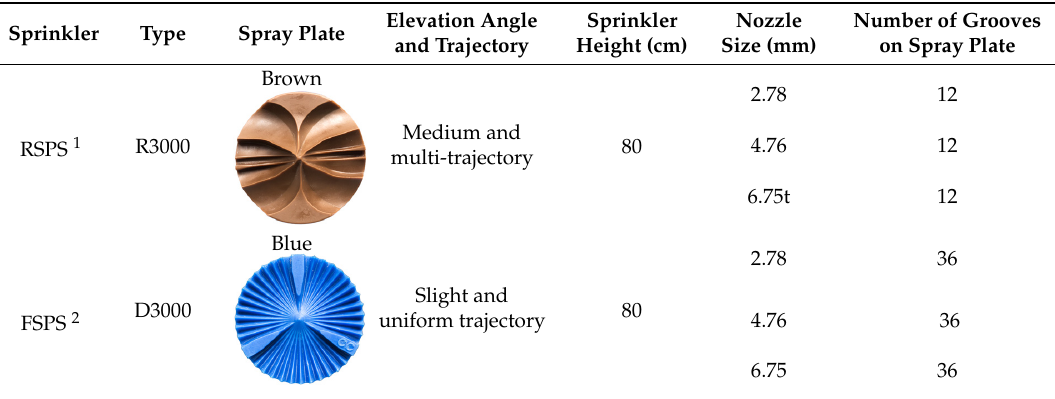
Table 2. Configuration parameters of the test sprinklers.